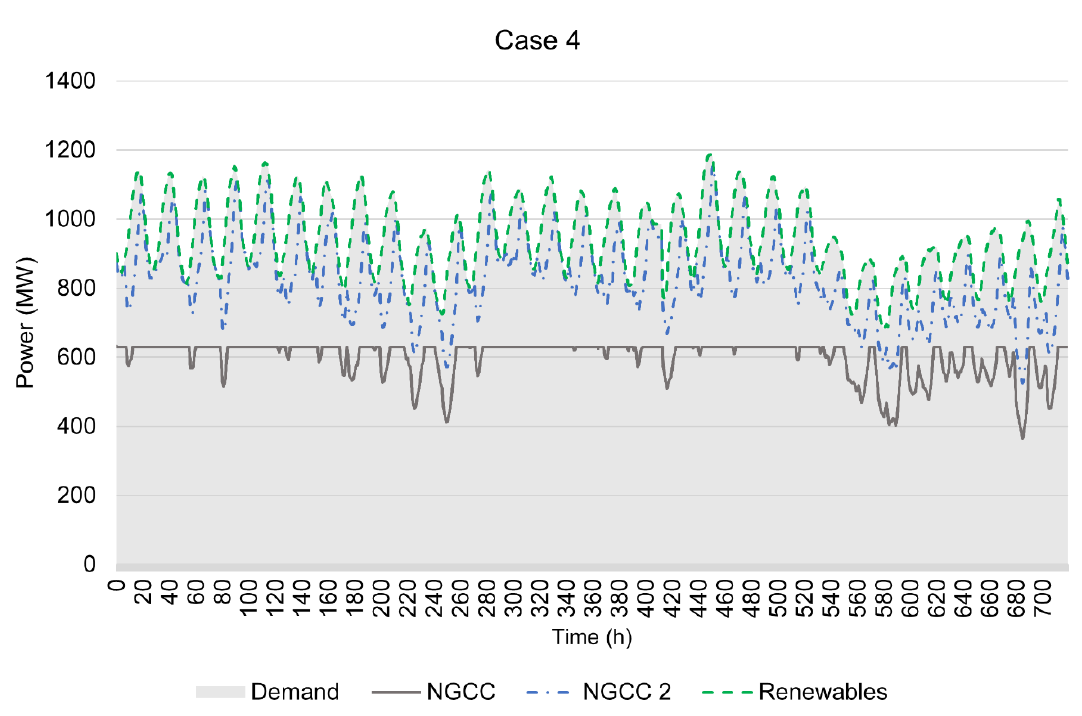
Figure 13. Power dispatch optimization result for Case 4.